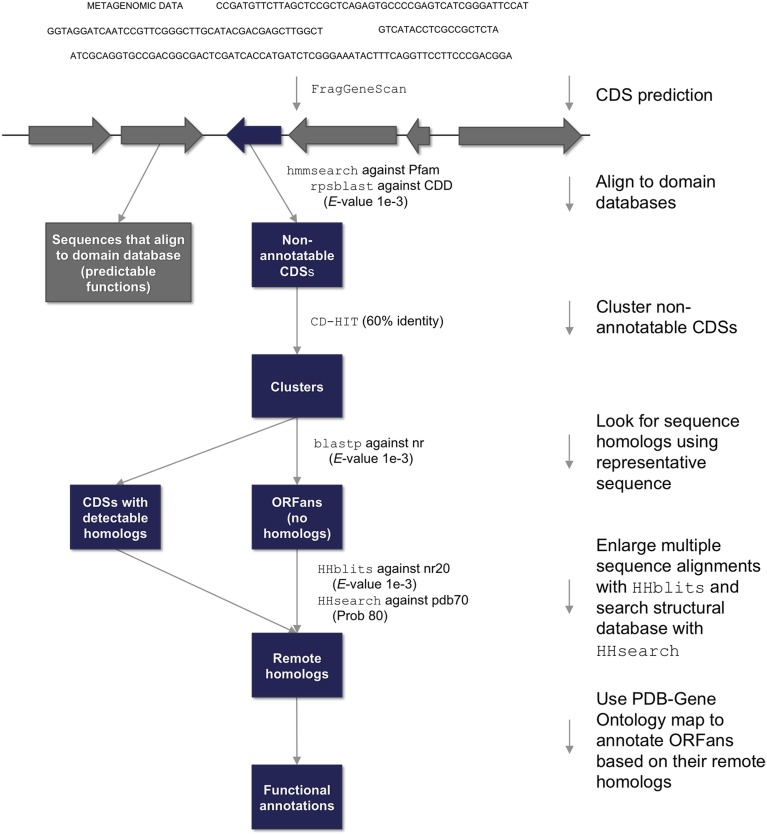
Pipeline for detection and functional annotation of metagenomic ORFan proteins. Protein-coding sequences (CDSs) were predicted from assembled metagenomic contigs, and searched against conserved domain databases. CDSs that could not be annotated by domain homology were further clustered, and representatives were BLASTed against the NCBI nr database. Remaining CDS clusters lacking detected homologs were considered ORFans, and these were subjected to remote homology detection using HHblits and HHsearch, which were used to perform profile-profile searches against the Protein Data Bank.